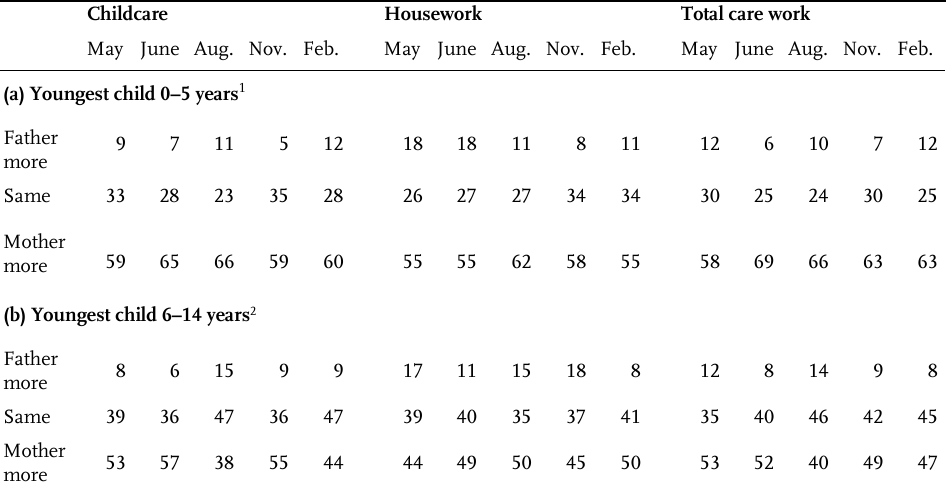
Table A8: Distribution of care work between mothers and fathers by age of the youngest child, in % Childcare Housework Total care work